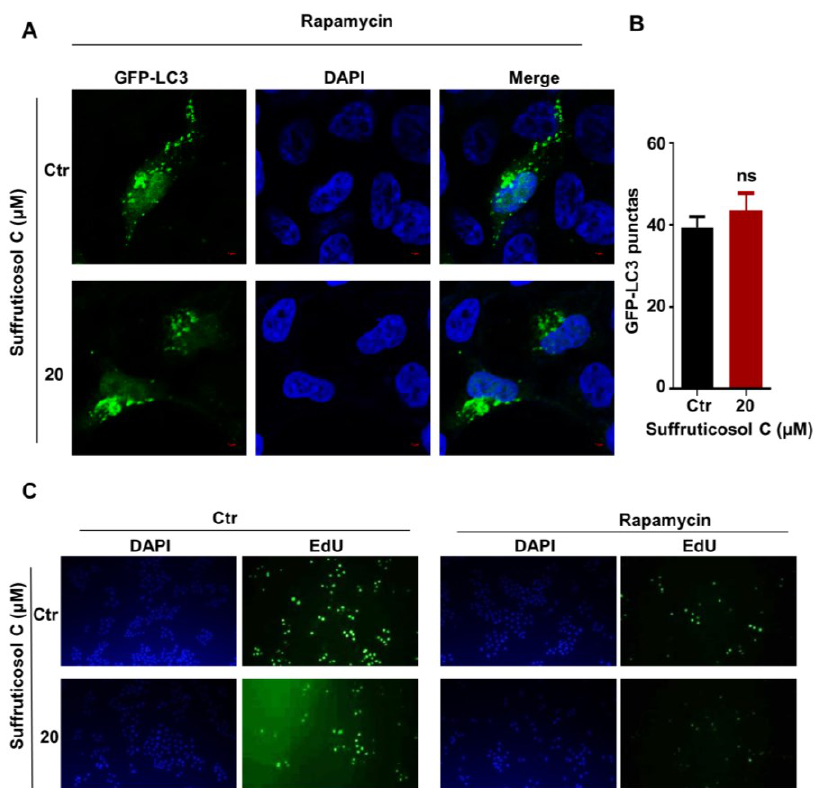
Figure 7. Suffruticosol C-induced autophagy and cell proliferation via inhibition of the mTORC1 pathway. HT29 cells were treated with rapamycin or in combination with suffruticosol C for 24 h, after which autophagy was analyzed by examining GFP-LC3 puncta ( A ). Quantitative data for the GFP-LC3 puncta are presented ( B ). ( C ). HT29 cells were treated with rapamycin or in combination with suffruticosol C for 24 h, after which a cell proliferation analysis was undertaken using an EdU assay. Data were analyzed by unpaired two-tailed Student’s t -test ( B ), and the results were expressed as Mean ± SEM ( B ). ns, not significant.